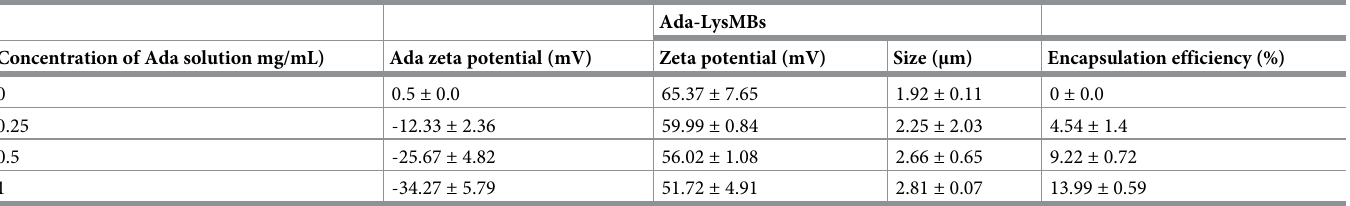
Table 1. Characterization of Ada and